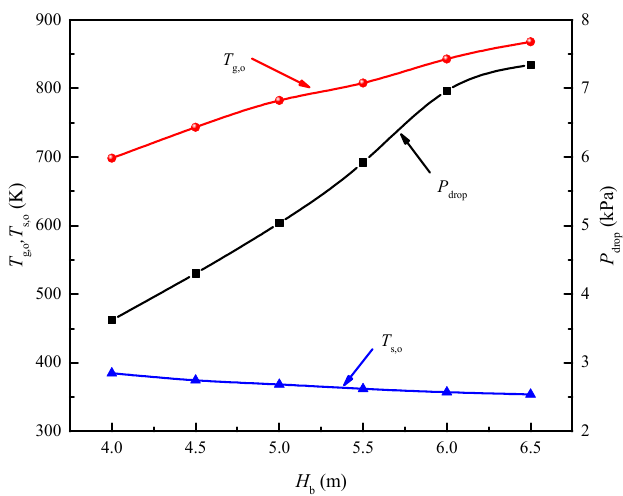
Figure 13. Effects of the height of the sinter bed on air and sinter outlet temperatures and the pressure drop of cooling air.